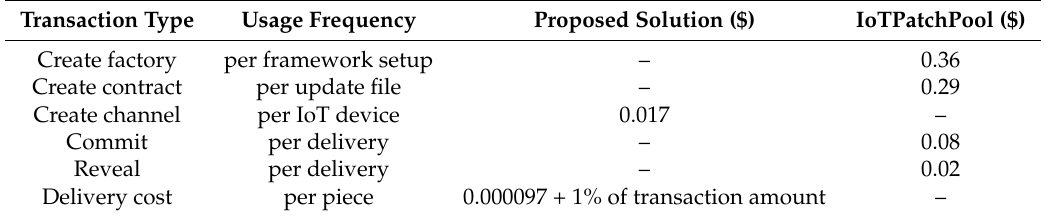
Table 5. Cost (in $) analysis and comparison with